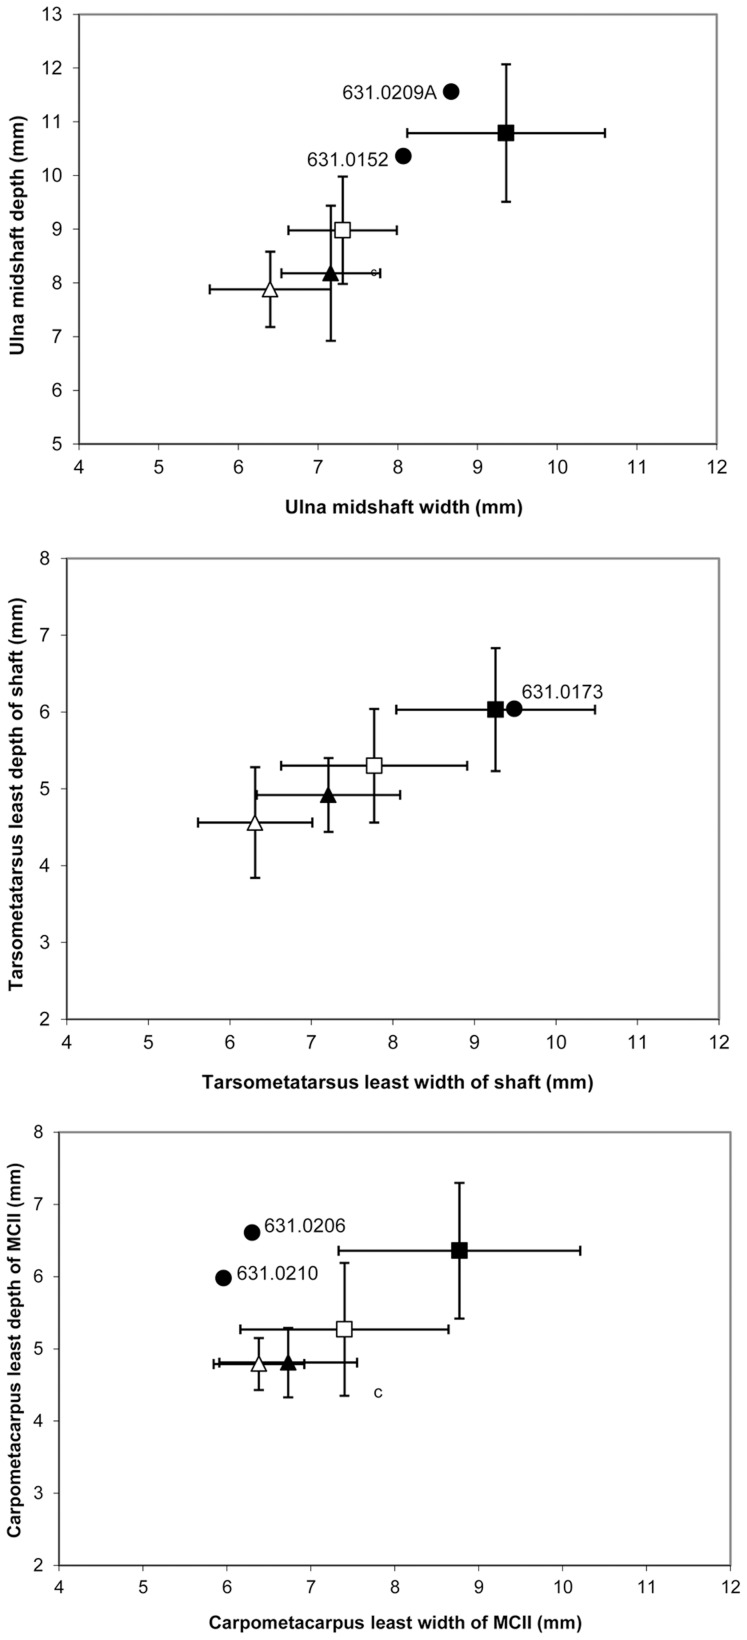
Archaeological turkey (•) osteometrics compared with mean (±2 standard deviations) M. gallopavo (male ▪, female ▴); and M. ocellata (male □, female ▵) [6].